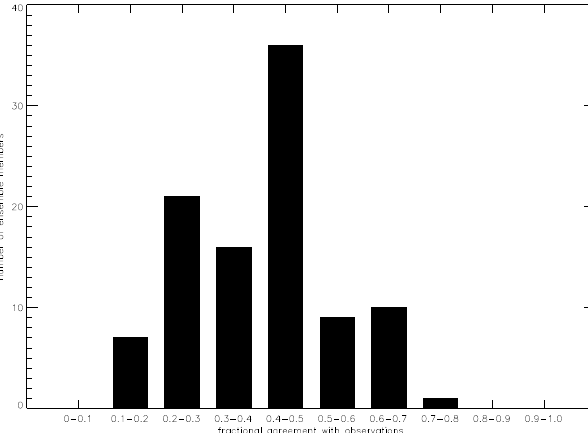
Fig. 3. Histogram of the fractional agreement between the 100 en- semble members and the observations over the Amazon region for all PFTs. Here, “fractional agreement”, gives the fraction of the 28 grid Amazonian grid boxes which are assigned the same PFT in the ensemble members and in